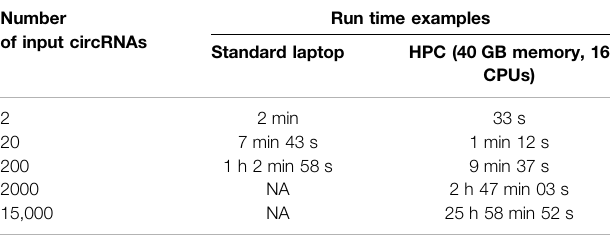
TABLE 3 | CIRCprimerXL is ef fi cient and can be used for large circRNA datasets. CIRCprimerXL duration times presented in this table are examples from single runs. The duration time can vary substantially based on the chosen